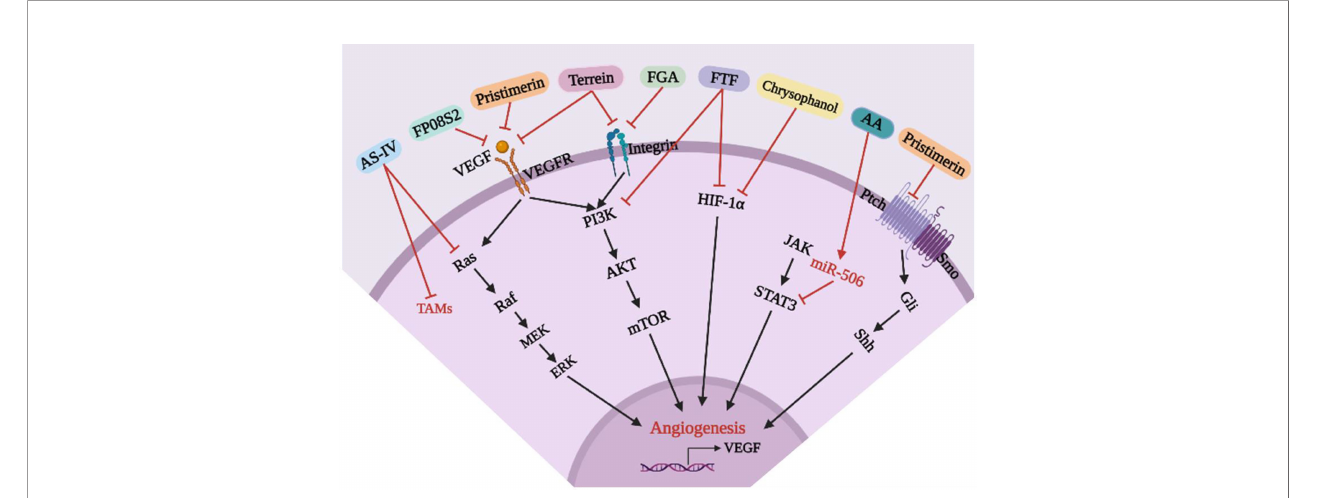
FIGURE 7 | Mechanism of anti-angiogenesis for existing natural compounds in lung cancer.